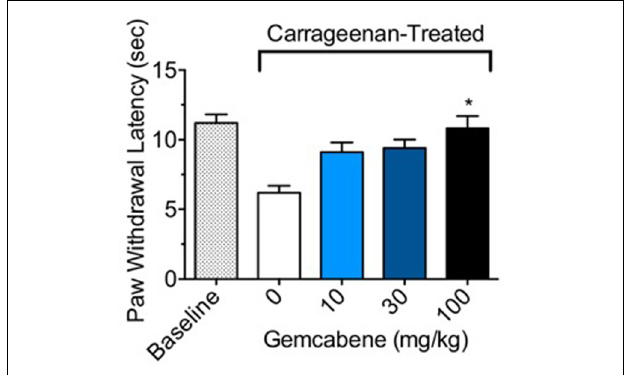
FIGURE 3 | Effect of gemcabene on carrageenan-induced thermal hyperalgesia in the male Sprague Dawley rats. To induce inflammation, male Sprague Dawley rats were anesthetized and given an intraplantar injection of carrageenan (2 mg) in saline (0.1 mL). Rats (8/group) were injected with either saline (baseline) or carrageenan (control and drug treated) into the hind paw. For measurement of PWL responses, tests were done 1-h post drug administration (3.5 h post saline/carrageenan injection). Dose-related effects of gemcabene on paw withdrawal latency (PWL) was determined following exposure to radiant heat. ∗ Significantly different from Carrageenan control. p < 0.05 as determined by one-way ANOVA/Tukey’s. Data are expressed as Mean ± SEM.